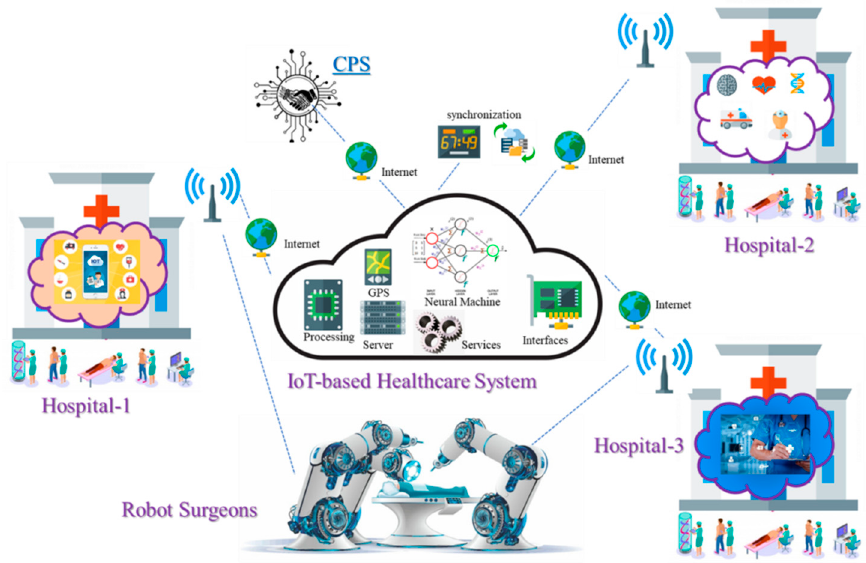
Figure 1. Internet of Medical Things (IoMT) enabled e-healthcare services.